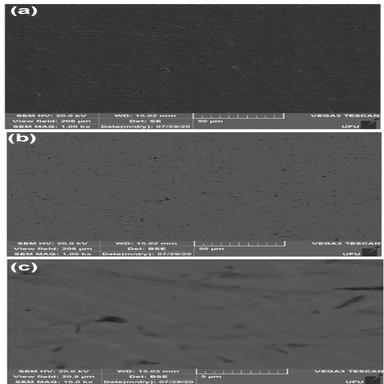
Surface SEM images of the Ti6Al4V alloy, (a) SE image with 1.0 kx magnification, (b) BSE image with 1.0 kx magnification, and (c) BSE image with 10.0 kx magnification.